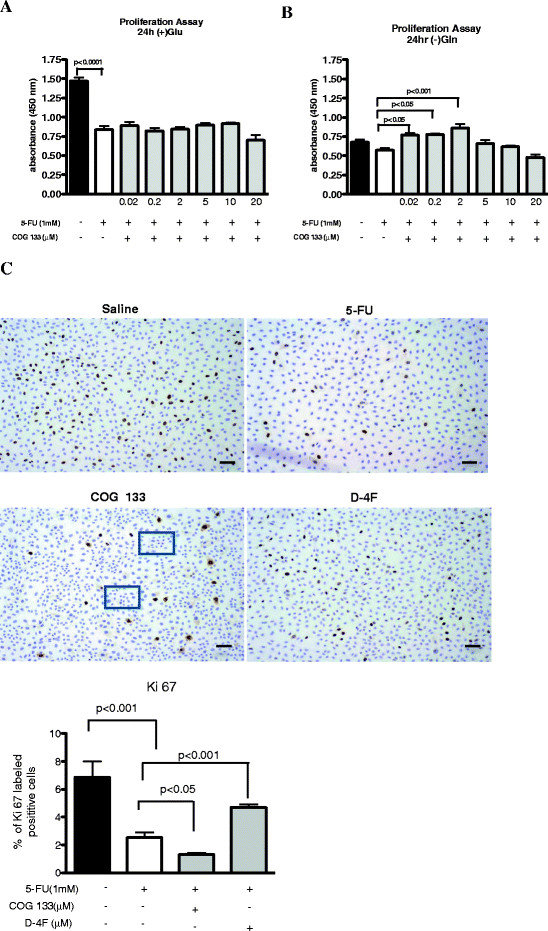
Dose response of the apoE COG 133 mimetic peptide (0.02-20 μM) on IEC-6 cell proliferation 24 h after 5-FU challenge (5-FU media exposure for 1 h) in glutamine-free media (A) or standard media (B), detected by formazan absorbance using an ELISA microplate reader at 450 nm in 96-well seeded IEC-6 cells. Values represent mean ± SEM and were analyzed by one-way ANOVA. (C) Ki67 immunolabeling of IEC-6 cells from chamber slides 24 h after 5-FU challenge (5-FU media exposure for 1 h) in glutamine-free media with either ApoE (COG 133) or ApoA-I (D-4F) peptides. Squares show areas of nested cells, suggesting a cloning cluster. Values represent mean% of Ki67-labeled cells in high magnified fields (X400) and were analyzed by one-way ANOVA.